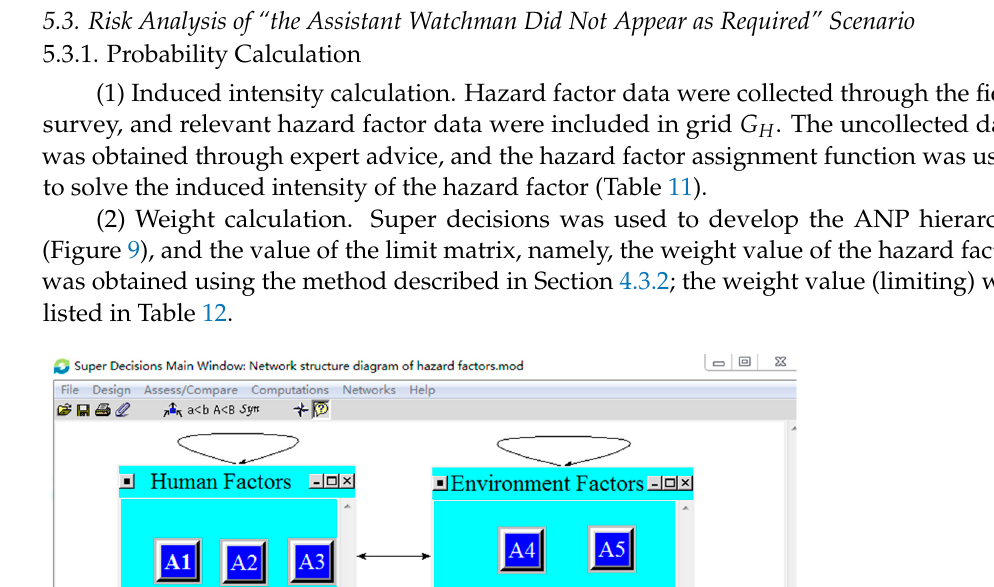
Figure 9. Network structure diagram of hazard factors in grid G H Table 12. Weight value of hazard factor in grid H G .